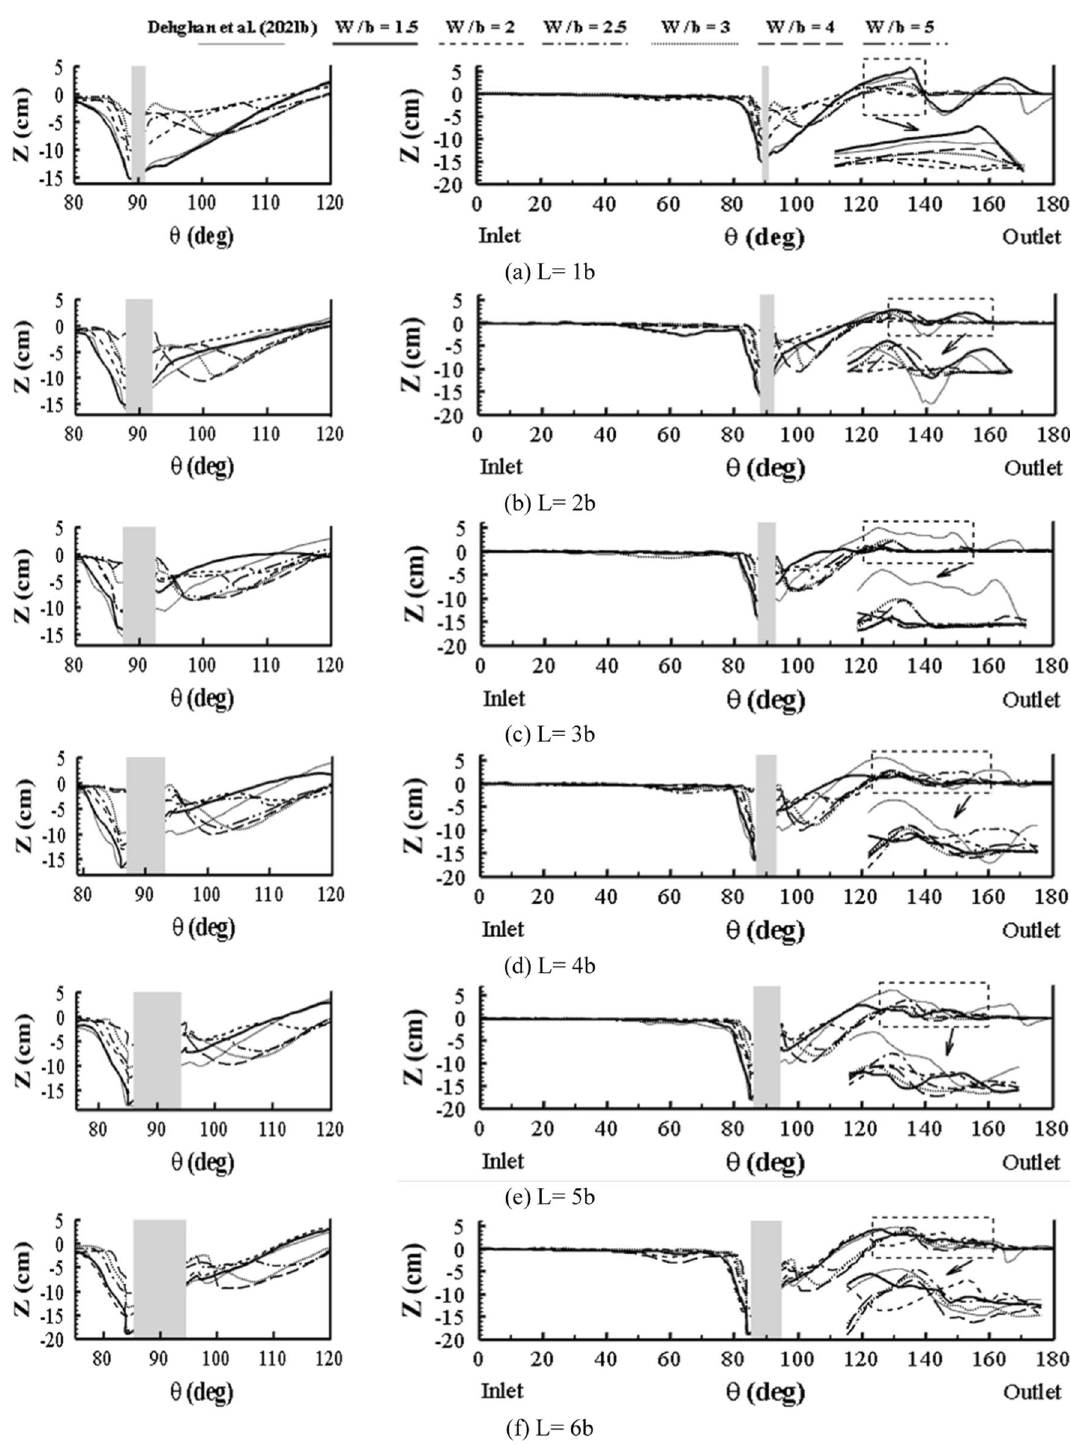
Fig. 9 Longitudinal sections in the center of channel width surrounding the combination of pier and various